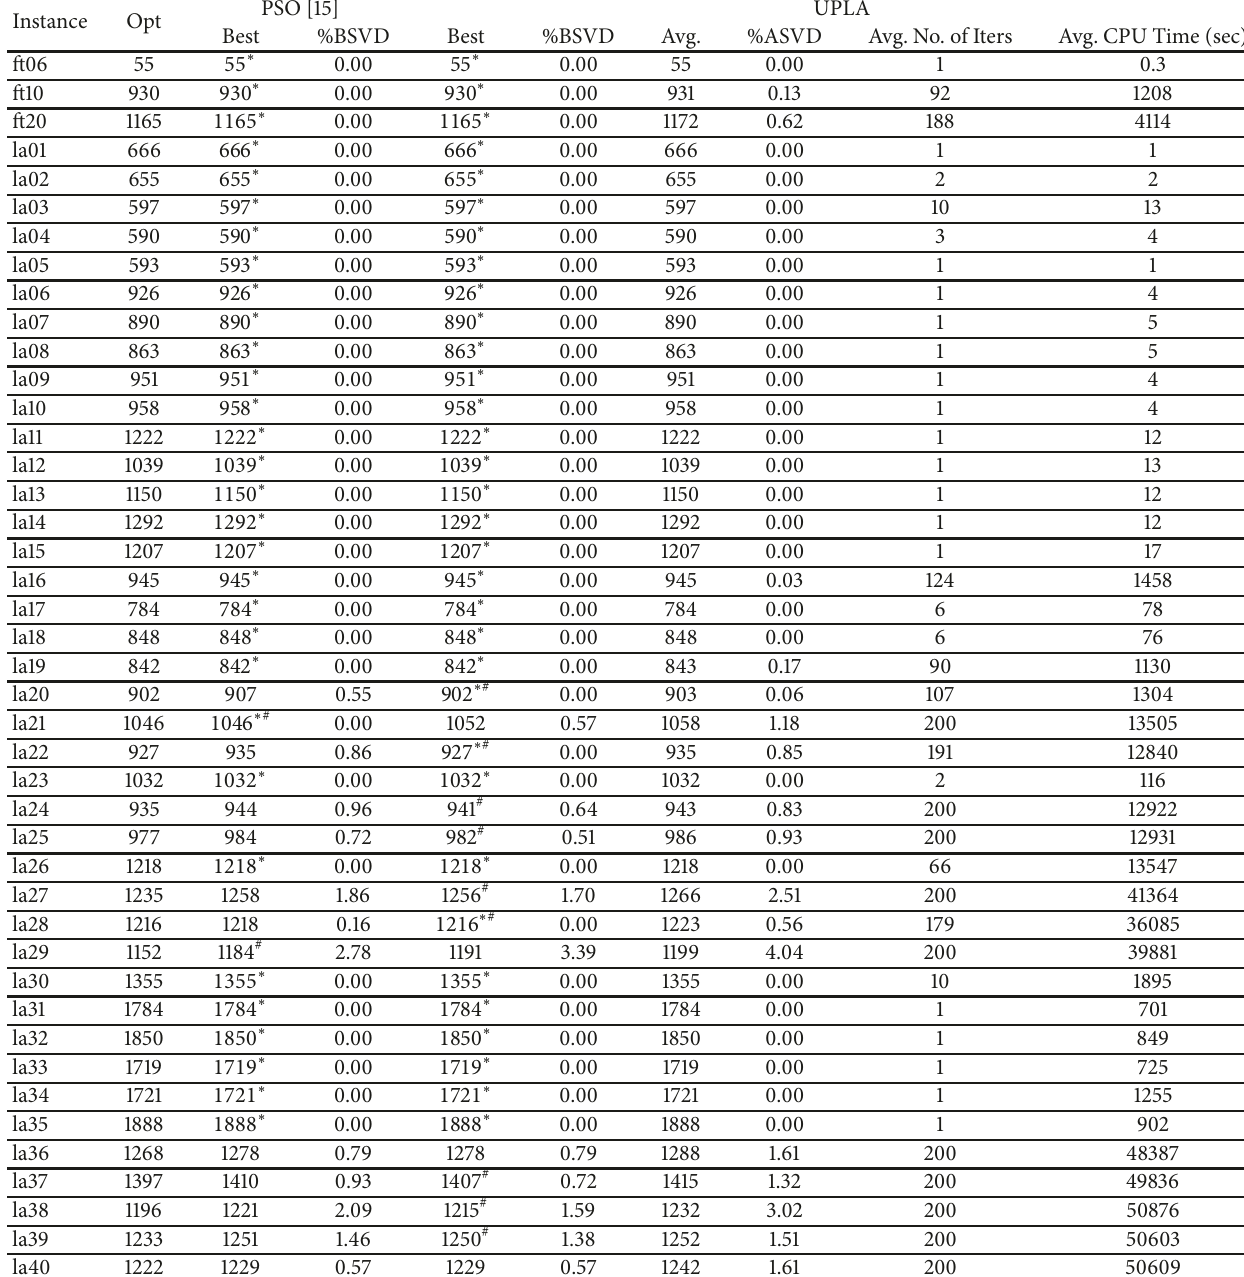
Table 2: Experiment’s results on the set of ft-and-la